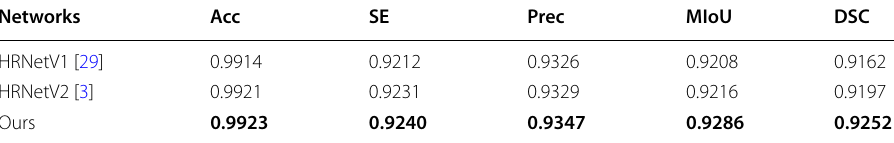
Table 4 Comparison of our method with other versions of HRNet, the highlighted values represent the best